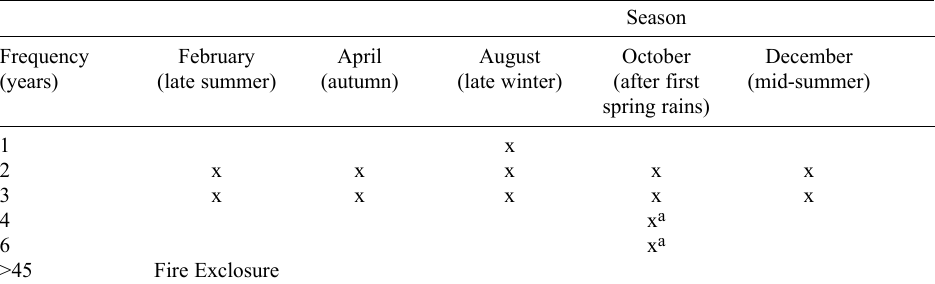
Current fire treatments applied in each replicate of the EBP trial. Treatments were started between 1954 and 1958. The four- and six-year treatments were started between 1976 and